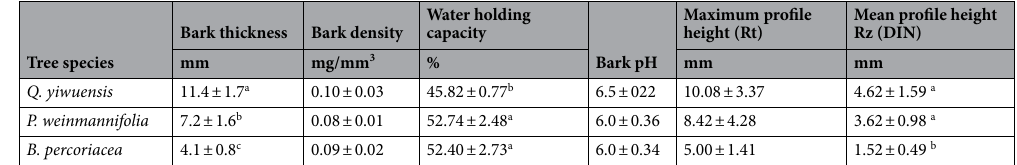
Table 1. Bark features in the 3 analysed species in the study area. Number of bark cores 3–6 from each tree, taken at different heights on the tree. Data shown are means and SD of four individual trees (bark thickness, density, WHC). Bark roughness was measured in situ with a 150 mm profile comb. Different lettering indicates significant differences at P ≤ 0.05.